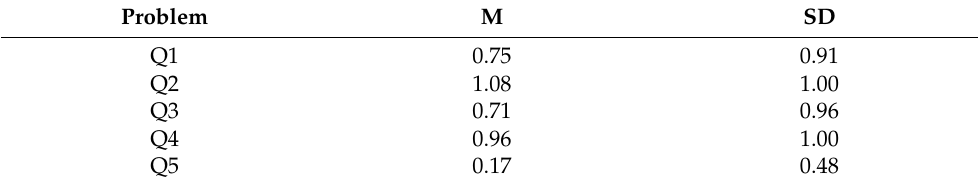
Table 10. Mean and deviation of each